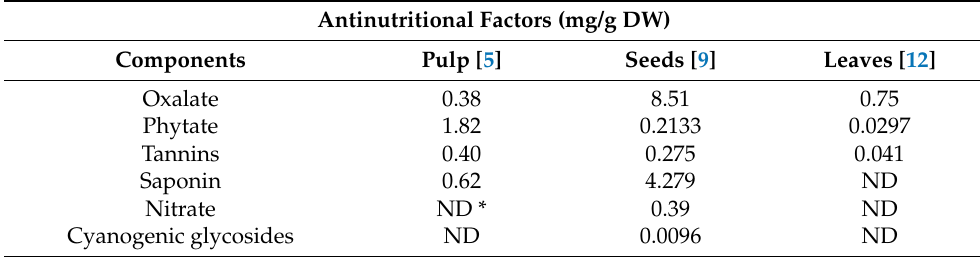
Table 4. Antinutritional components of desert date pulp, seeds and